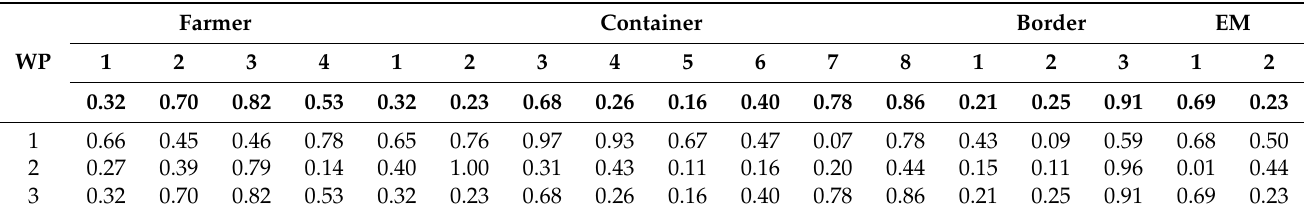
Table 1. Three examples of WPs.